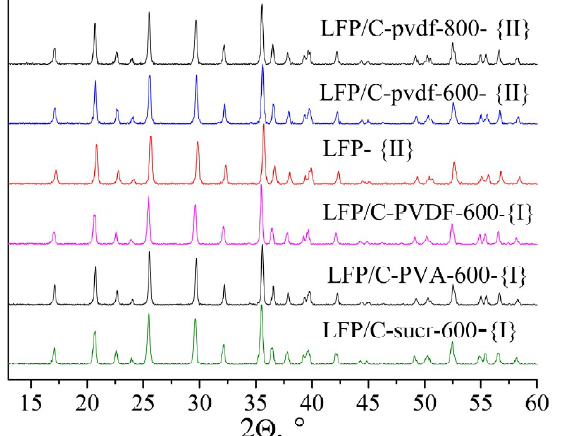
Fig. 1. X-ray diffraction patterns of a series of the prepared